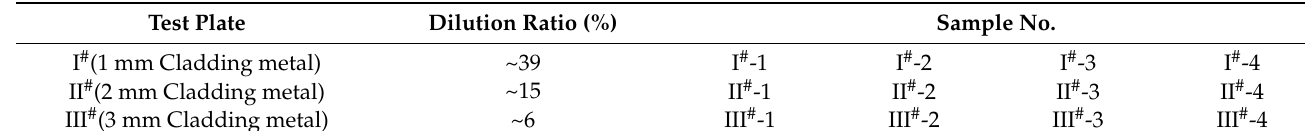
Table 4. Varestraint test of samples.